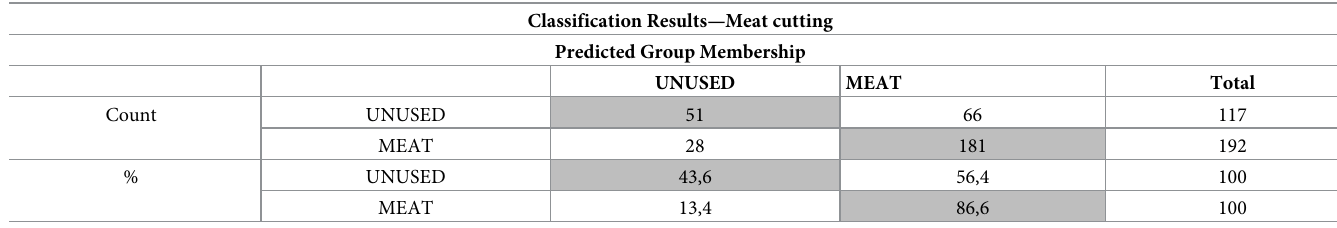
Table 3. Results of classification of meat-cutting and unused surfaces by quadratic discriminant analysis. A high proportion of the unused surfaces (56.4%) are wrongly classified as meat-cutting. Shaded cells indicate the correct